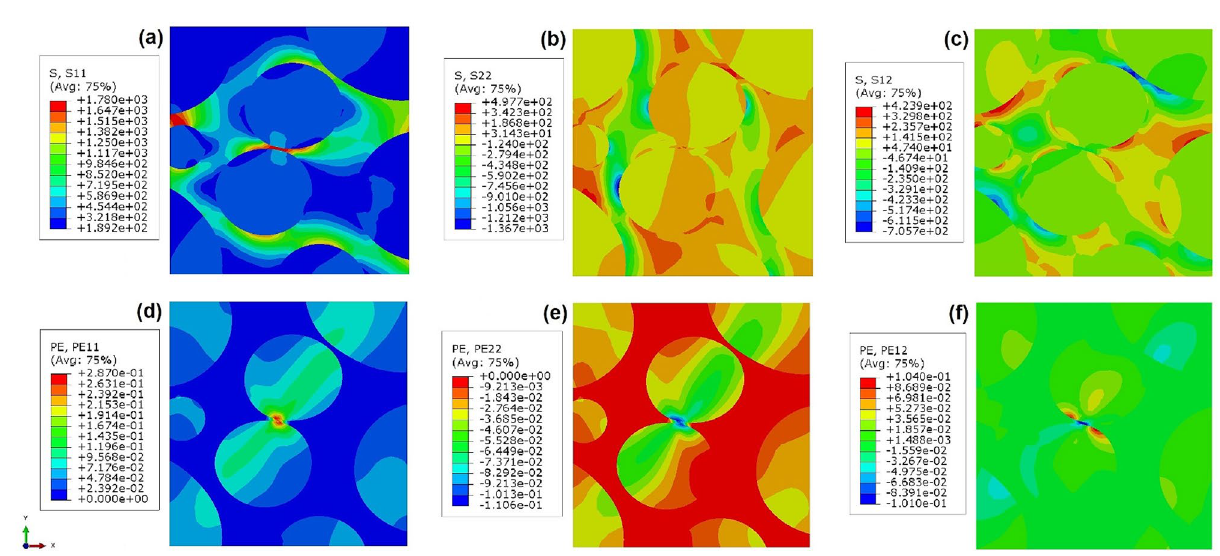
Figure 5. Distribution of normal x , y , and shear xy stresses ( a – c ) and plastic strain ( d – f ) tensor components at a global strain ε eff = 0.04 in representative cells of bR